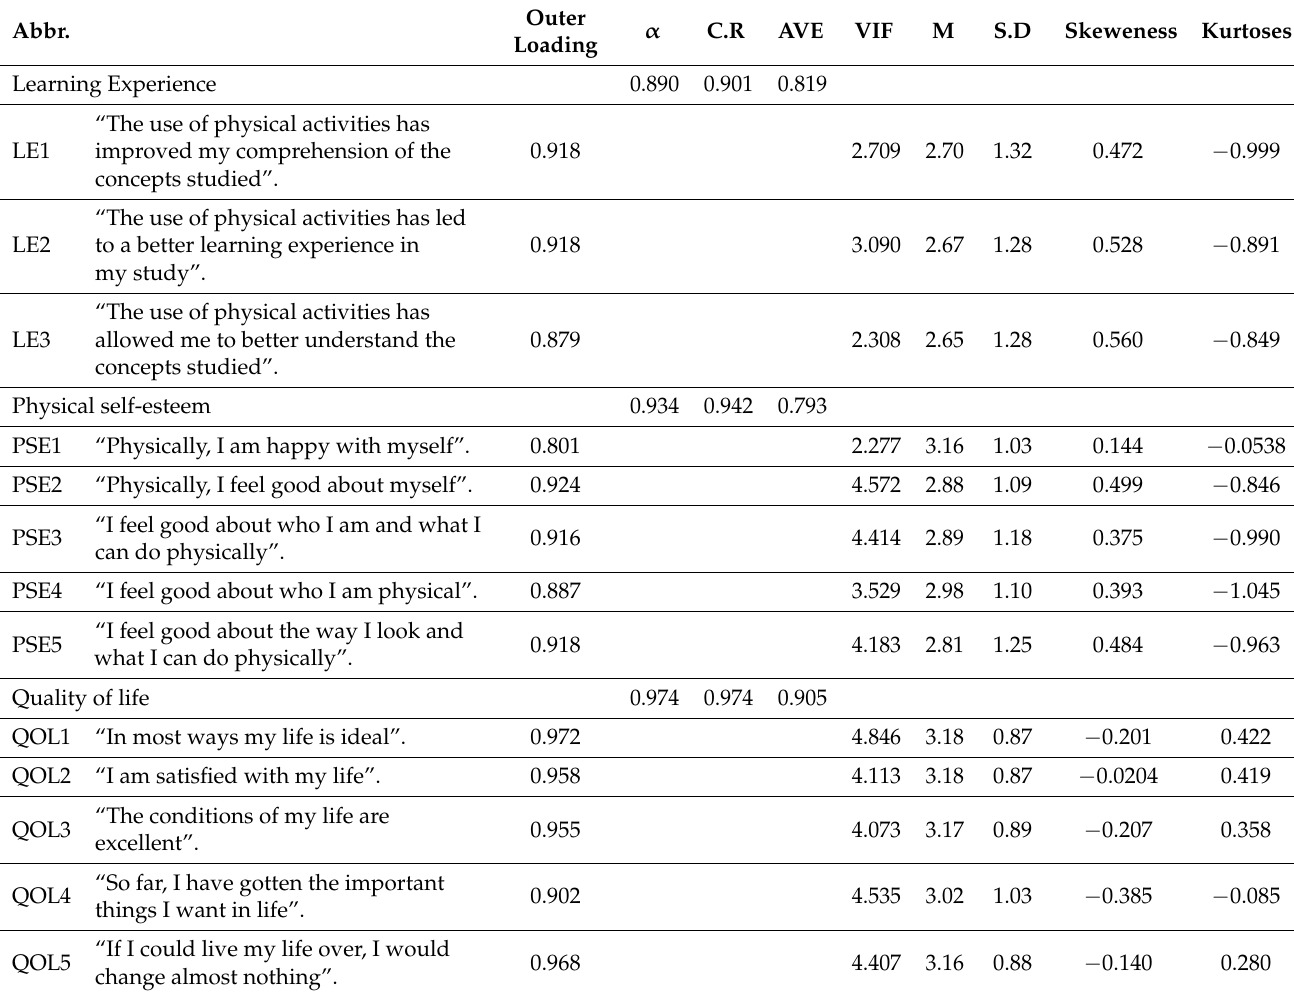
Table 2. Evaluation of the Outer Measurement Model ( a , C.R, and AVE) and multi-collinearity (VIF), M, S.D, Skewness, and Kurtoses